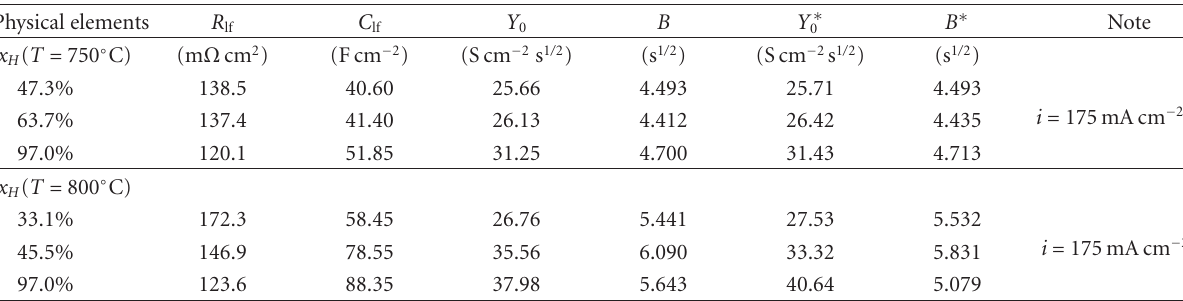
Table 1: Values for a parallel RC as shown in Figure 5(a) are fitted to the low-frequency impedance loops of button cells. (a) Varying hydrogen feed concentration at two temperatures